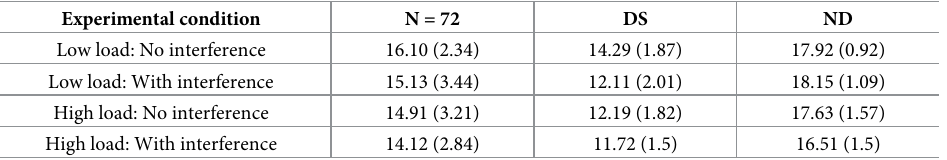
Table 4. Experimental task by load and interference: Mean (standard deviation).